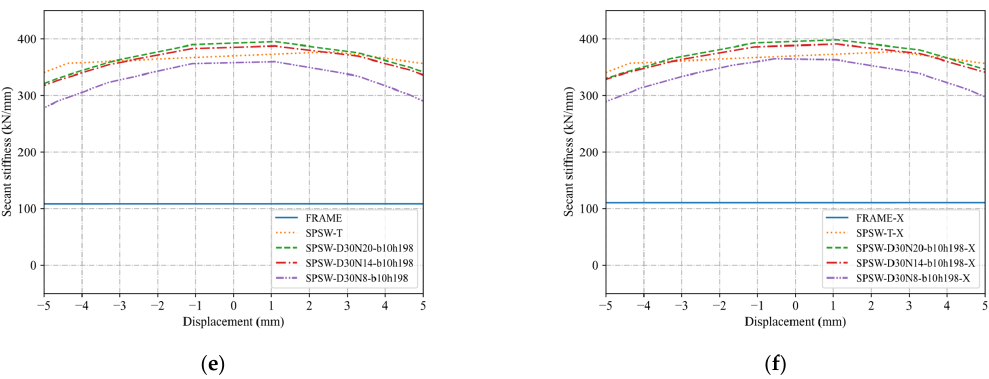
Figure 14. Comparison between the secant stiffness reduction curves of different models separately with and without frame beam flange constraints: ( a ) without frame beam flange constraints under monotonic loading; ( b ) without frame beam flange constraints under cyclic loading; ( c ) with frame beam fl ange constraints under monotonic loading; ( d ) with frame beam fl ange constraints under